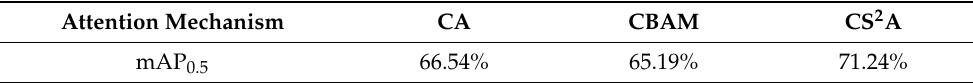
Table 5. Training results 2.